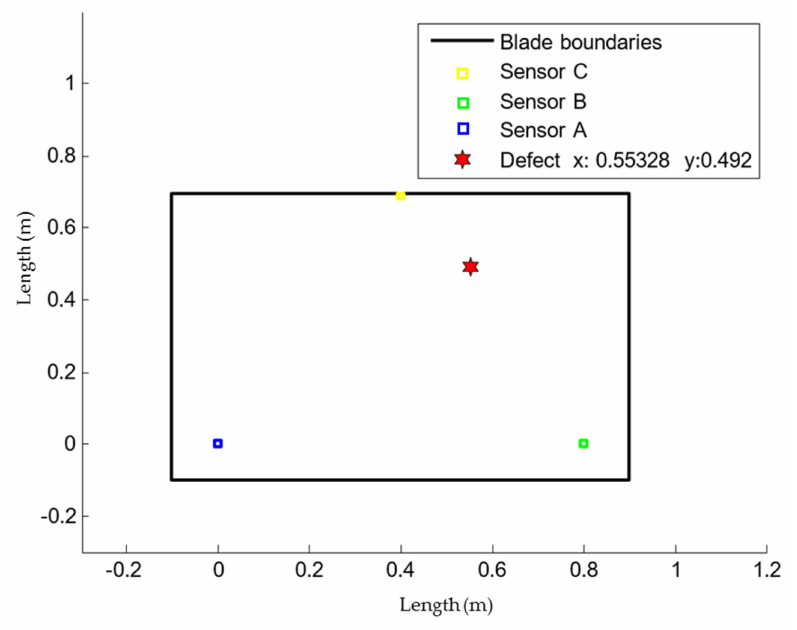
Figure 14. Scheme of the location of the acoustic emission for the first case